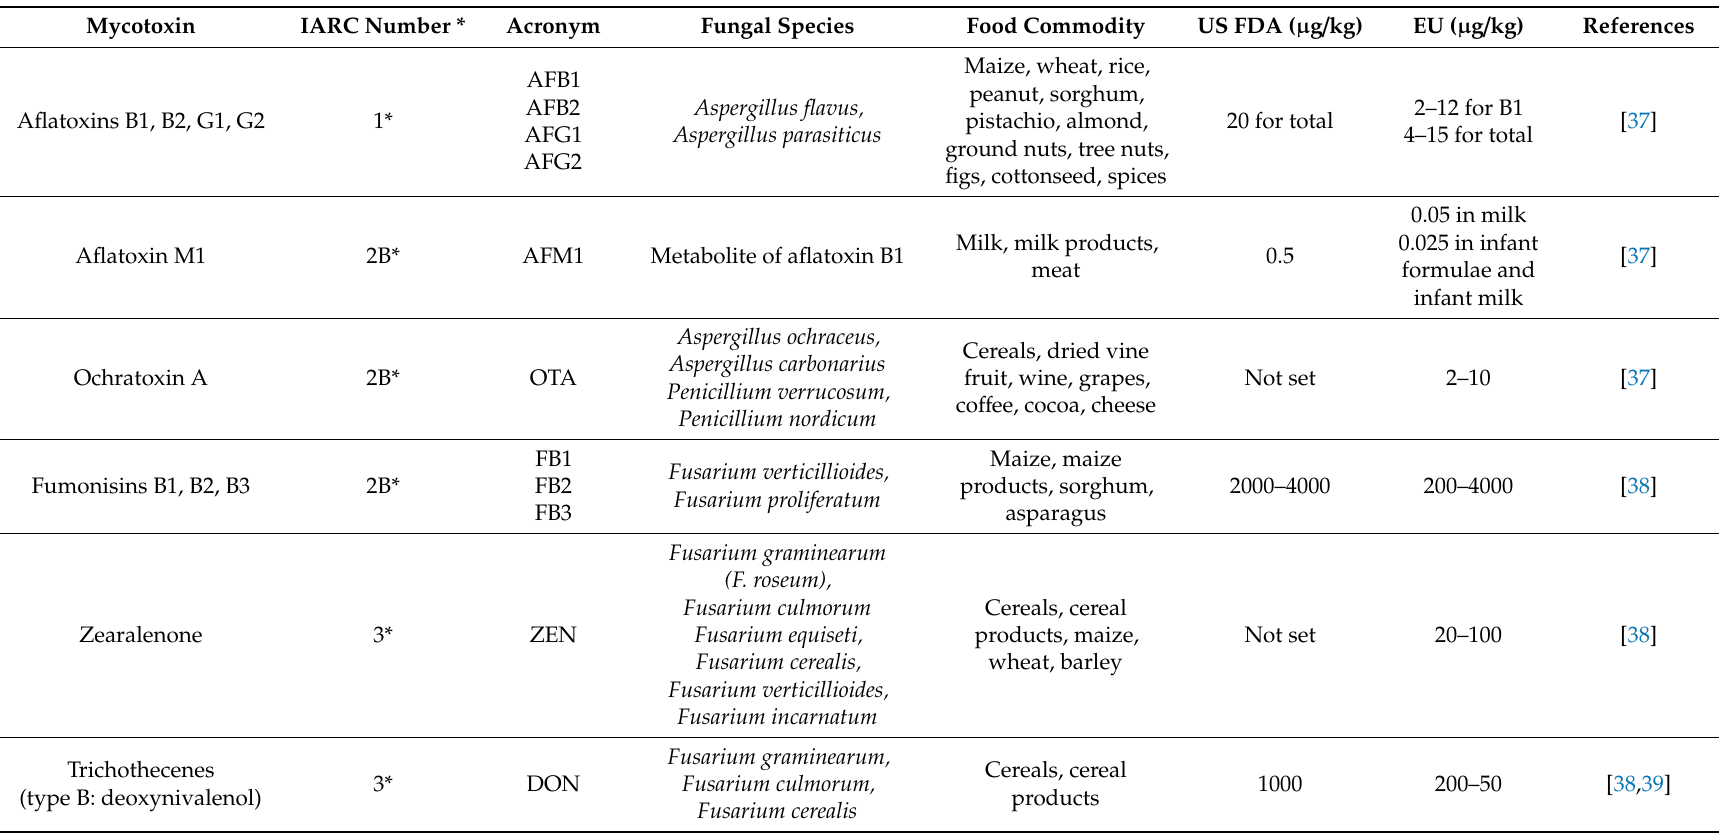
Table 1. Most important mycotoxins and the United States (US) and European Union (EU) limits on food and animal feed levels. FDA—Food and Drug Administration; IARC—International Agency of Research on